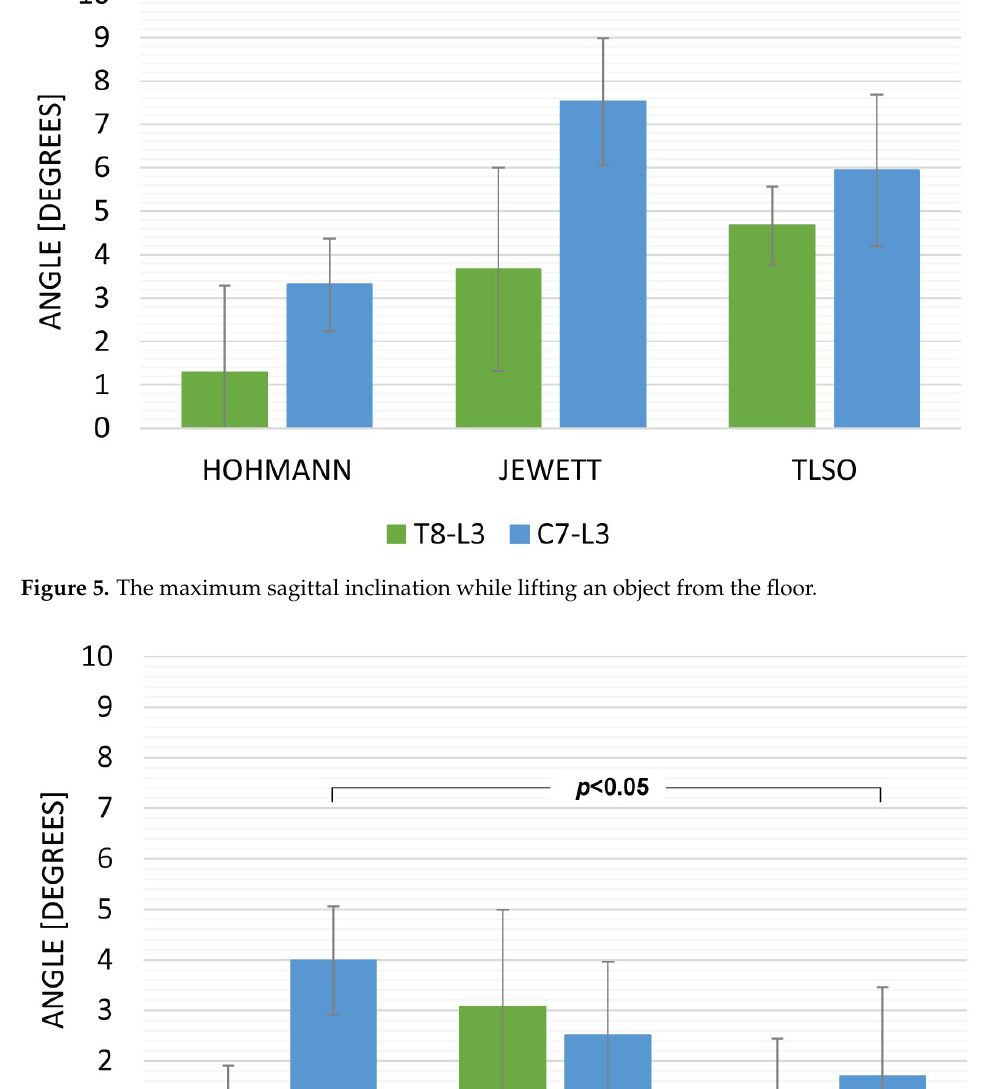
Figure 4. The maximum sagittal inclination while walking.